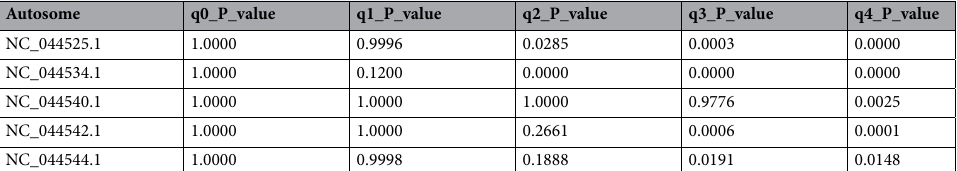
Table 1. Mann–Whitney U test P -values for autosomes showing significantly higher alpha diversities in dromedaries than Bactrian camels at different diversity orders